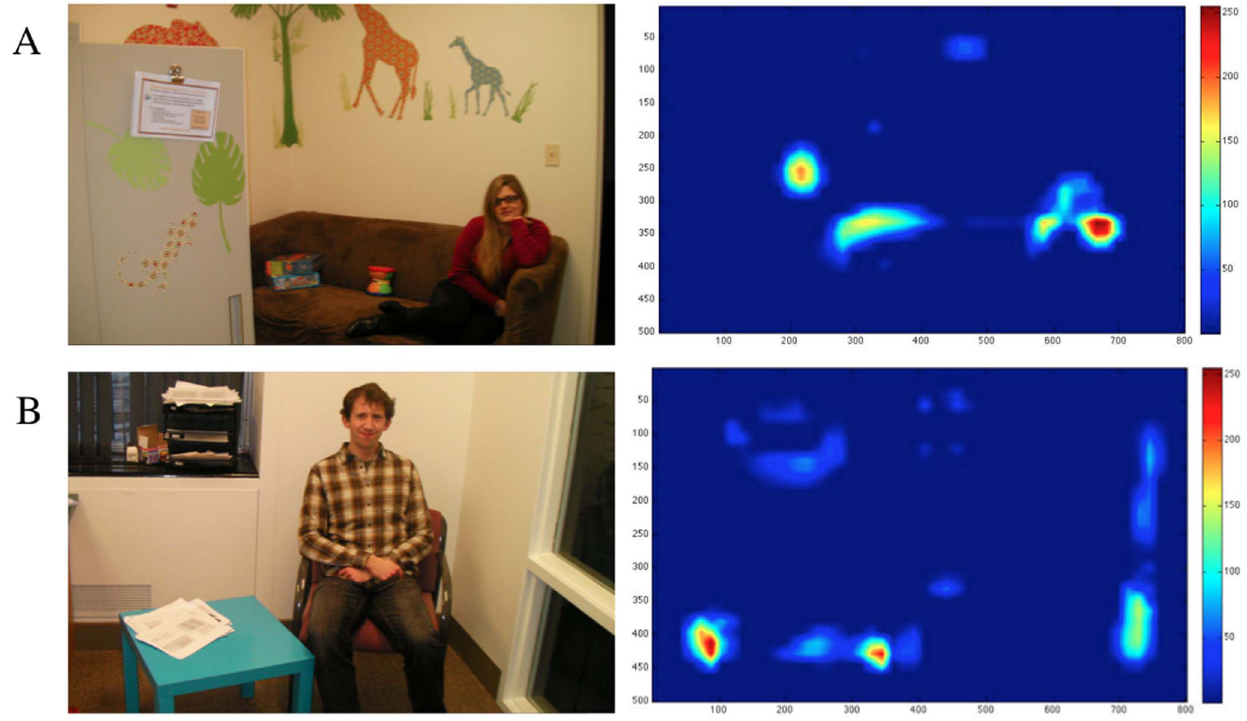
Figure 1. Illustrates images shown to participants and associated saliency heat maps. Hot colors represent higher salience locations. A) Face is winner-take-all most salient area in display as determined by the MATLAB SaliencyToolbox [24]. B) Non-Salient Face example image where faces are not most salient area in the display. Individuals in photographs have given written informed consent, as outlined in the PLOS consent form, to publication of their photograph.